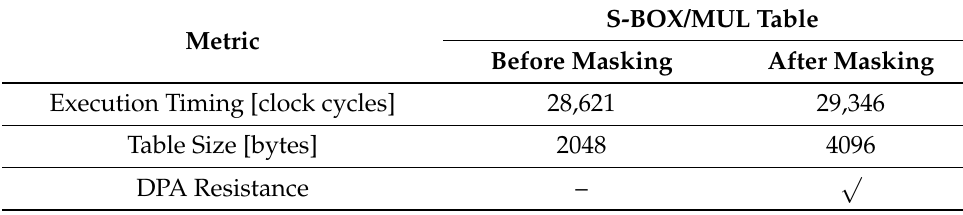
Table 4. Performance comparison result on the ARM